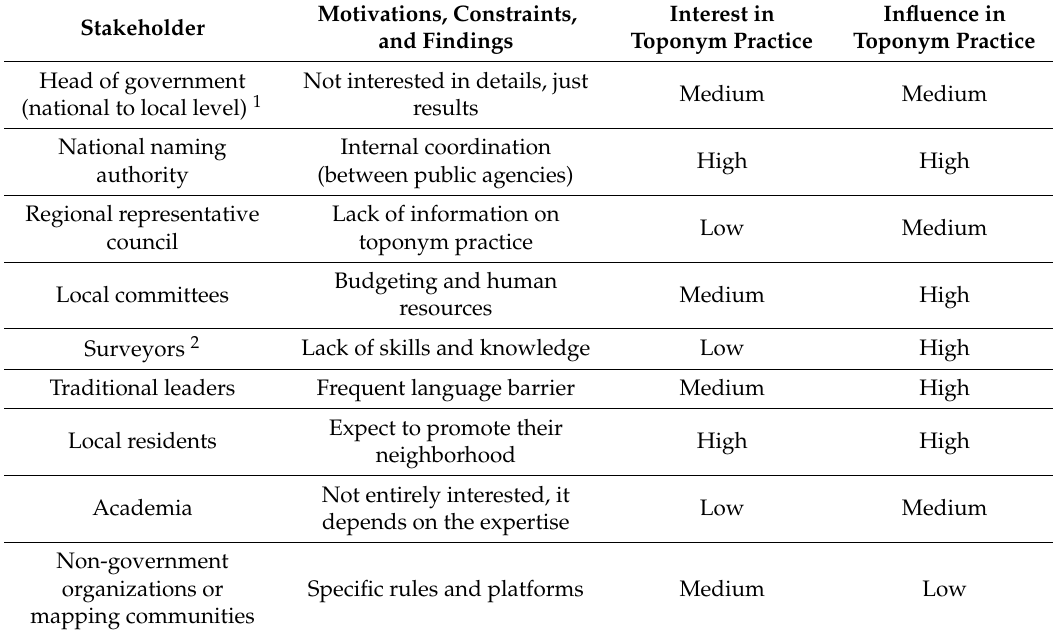
Table 2. Stakeholder analysis